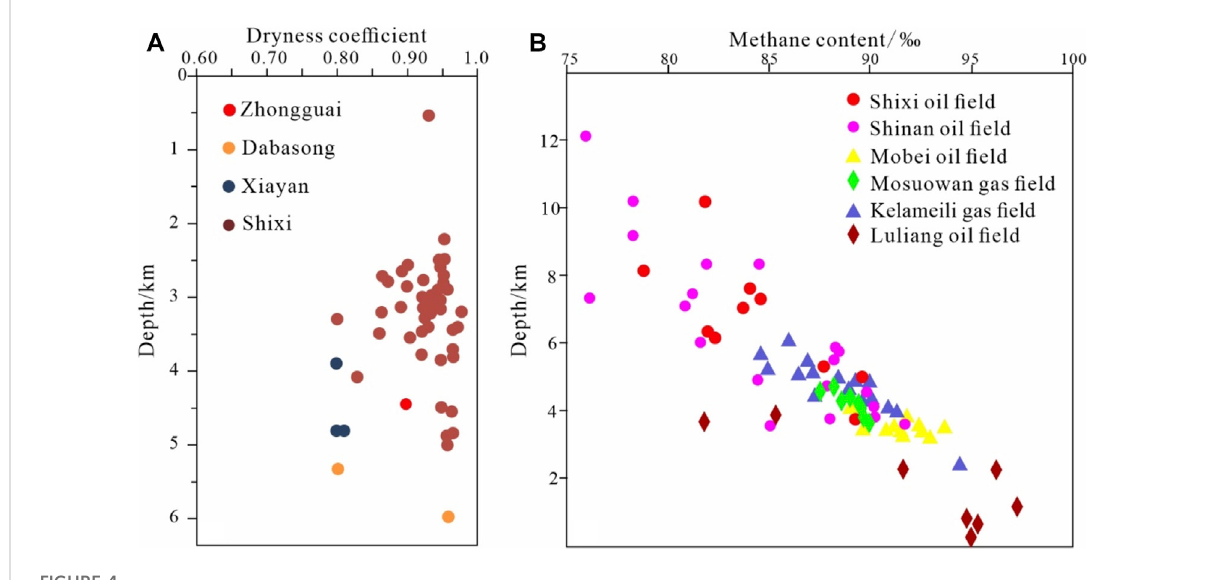
FIGURE 4 (A) Dryness coef fi cient and (B) methane content versus depth in the Penyijingxi Sag.